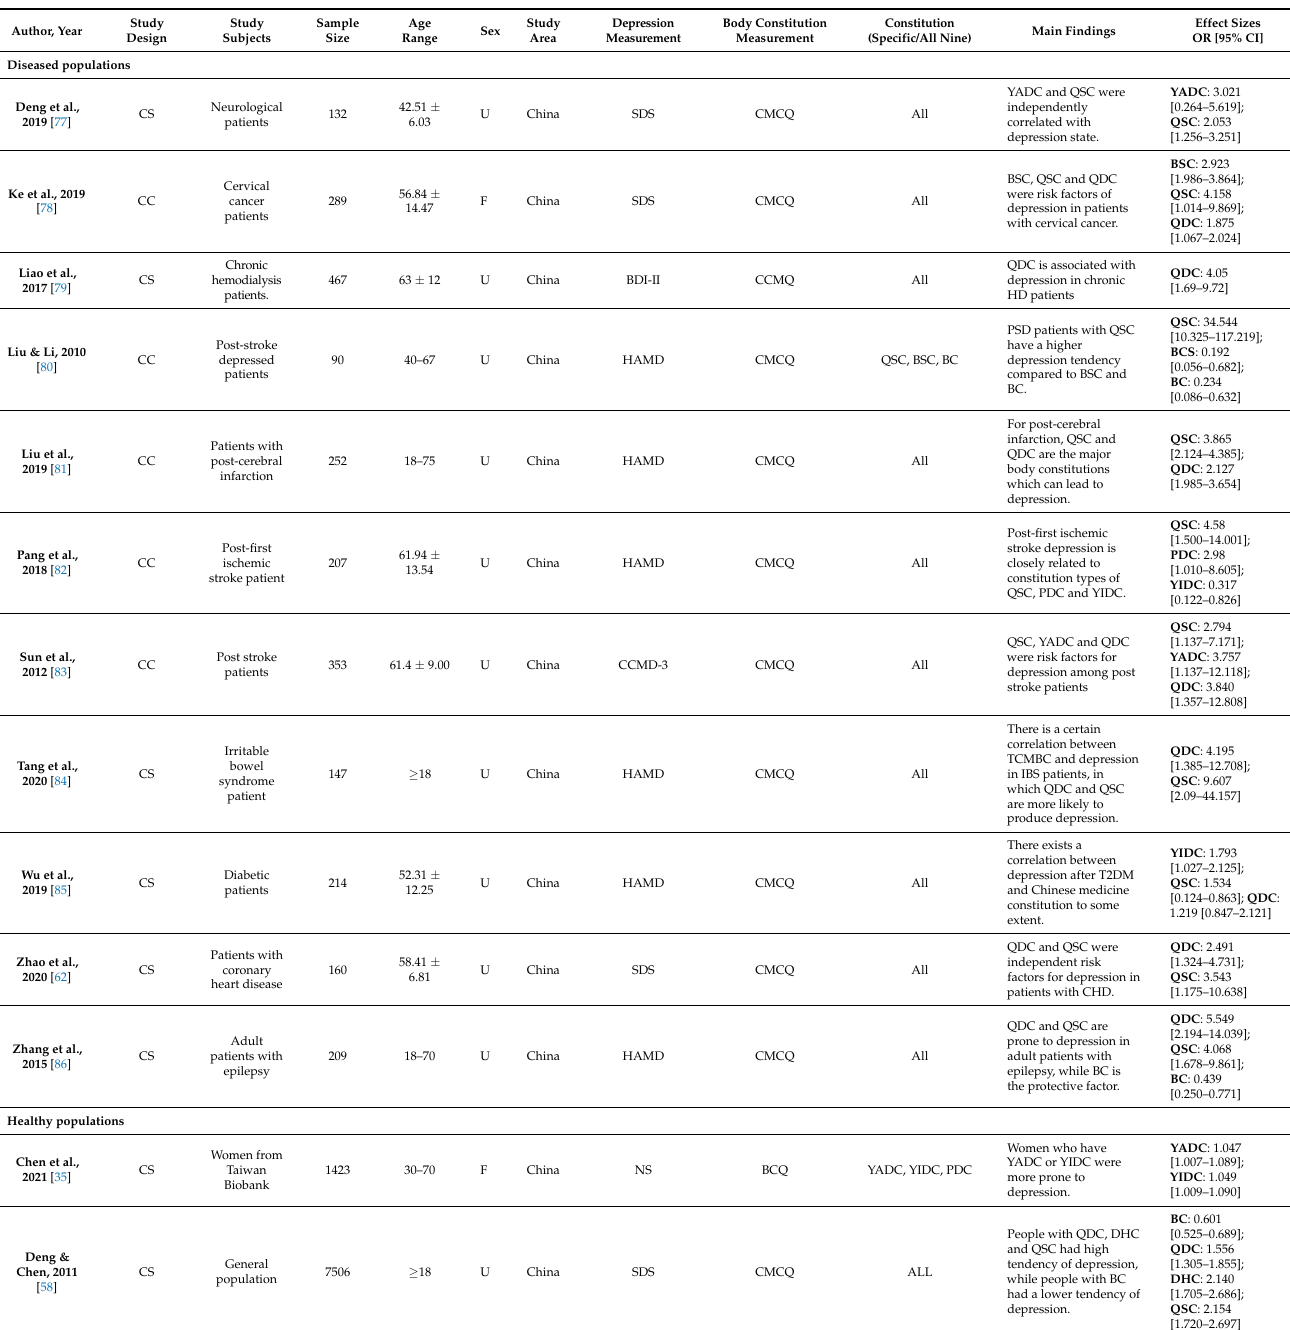
Table 2. Characteristics of included studies.